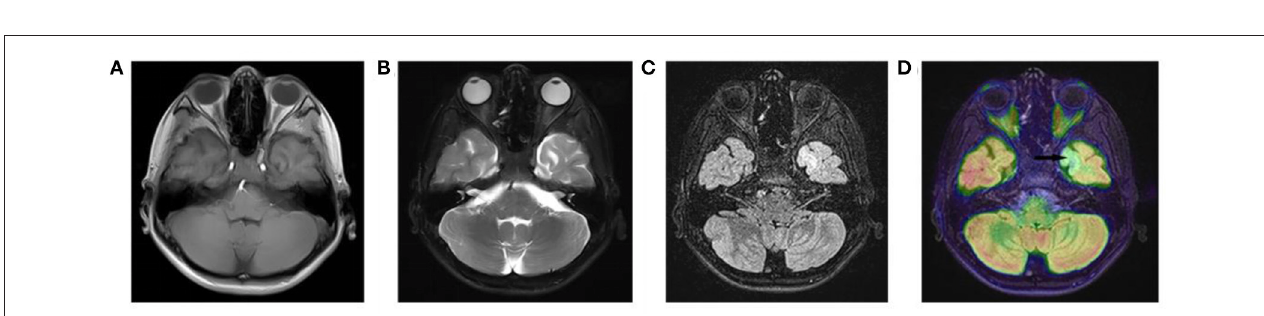
chain (C8A). Specifically, the folding changes of these proteins ranged from 1.5 to 43.2. Among them, 97 (88.18%) proteins fold varied between 1.5 and 5, 10 (9.09%) proteins fold varied between 5 and 10 times, and 3 (2.73%) proteins fold varied between 10 and 50